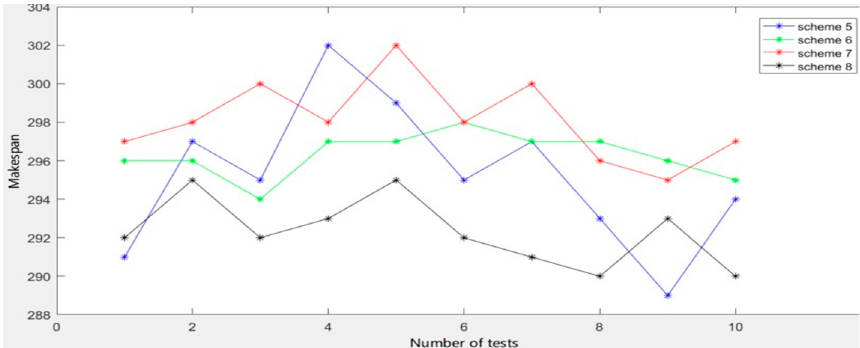
Figure 7. Results of 10 instance tests.